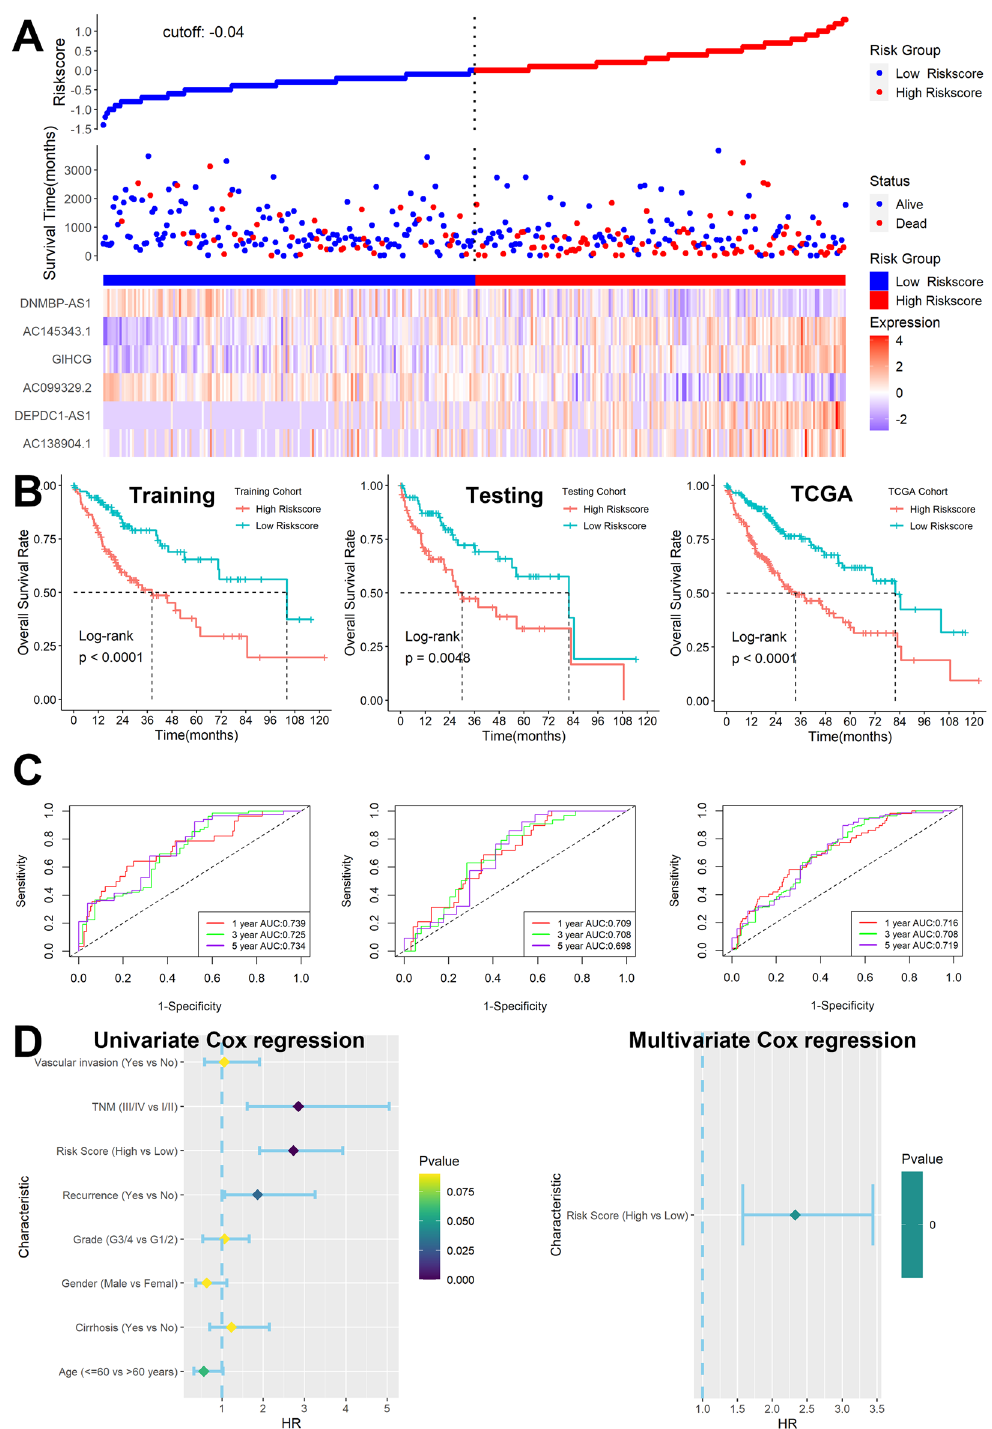
Figure 4. Construction of Cuproptosis-associated lncRNA signature in TCGA. ( A ) The distribution of risk scores, OS status, and expression profiles of the six lncRNAs. ( B ) Patients with higher risk scores had significantly decreased survival outcomes in training, testing, and TCGA cohorts. ( C ) ROC analysis in the three cohorts. ( D ) The Cuproptosis-associated lncRNA signature was shown to be an independent risk factor for patients’ overall survival in